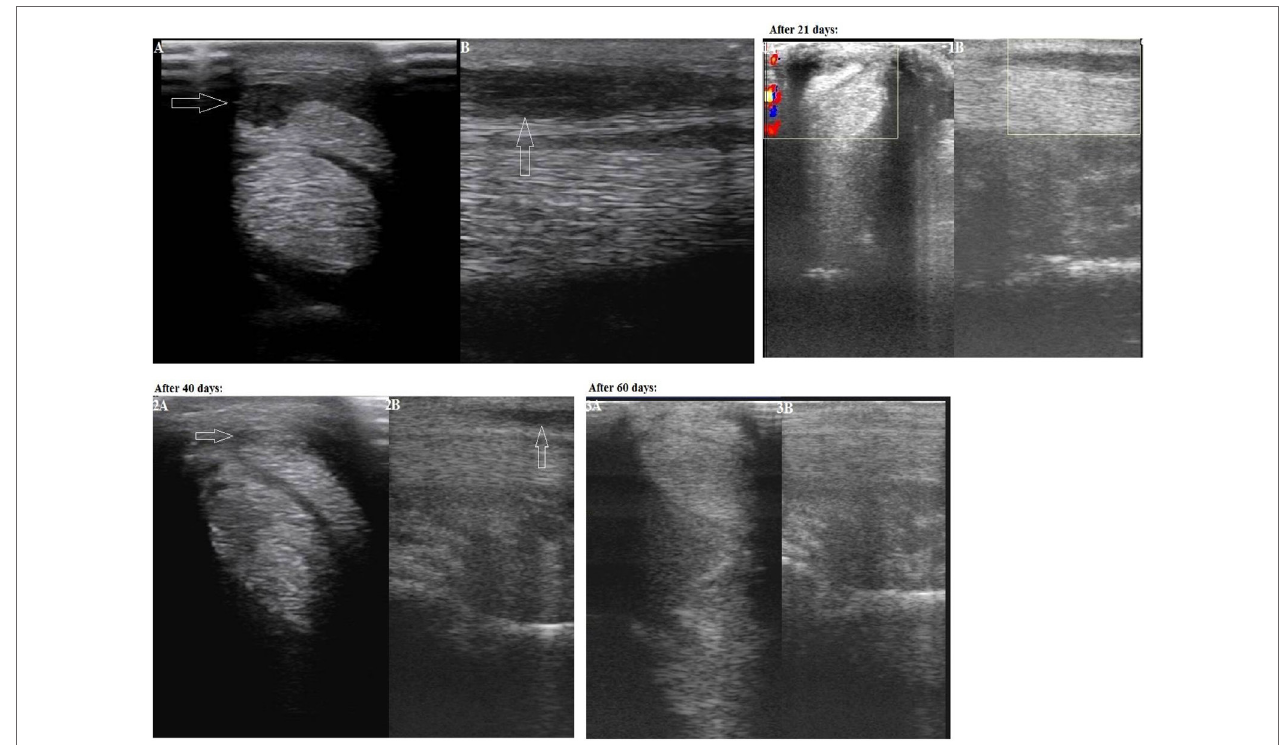
FIGURe 2 | Second case—transverse (Panel A) and longitudinal (Panel B) projections of the superficial digital flexor tendon in zone 2B on an ultrasound image (an arrow indicates an anechoic and hypoechoic zone of the injury). Panels 1A and 1B: on Day 21 after the plasmid DNA (pDNA) administration. Panels 2A and 2B: on Day 40 after the pDNA administration. Panels 3A and 3B: on Day 60 after the pDNA